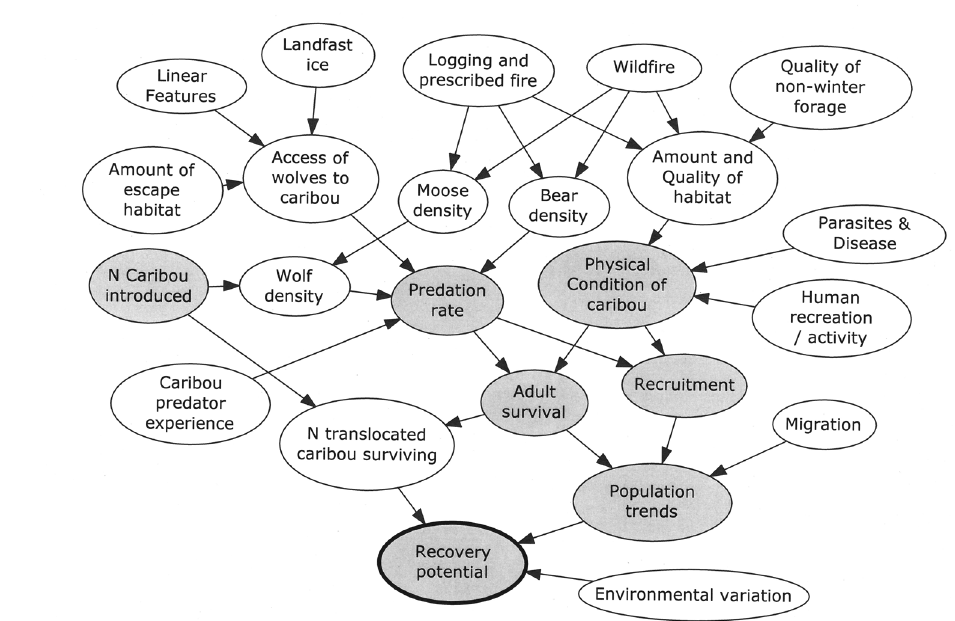
Figure 1. Influence diagram underlying a Bayesian Belief Network for a proposed woodland caribou translocation into Pukaskwa National Park. Grey shaded nodes are those presented in Table 1; the resultant (outcome) node has a thicker